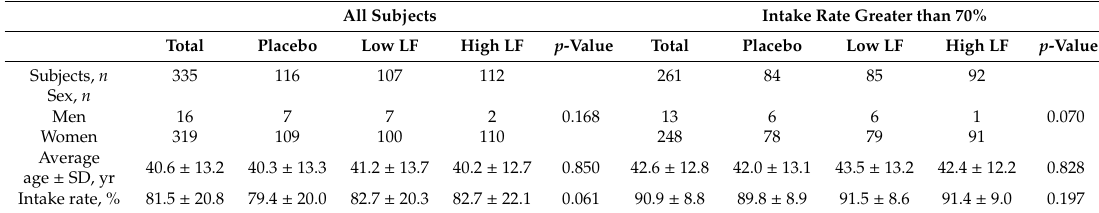
Table 1. Baseline demographic and clinical characteristics.